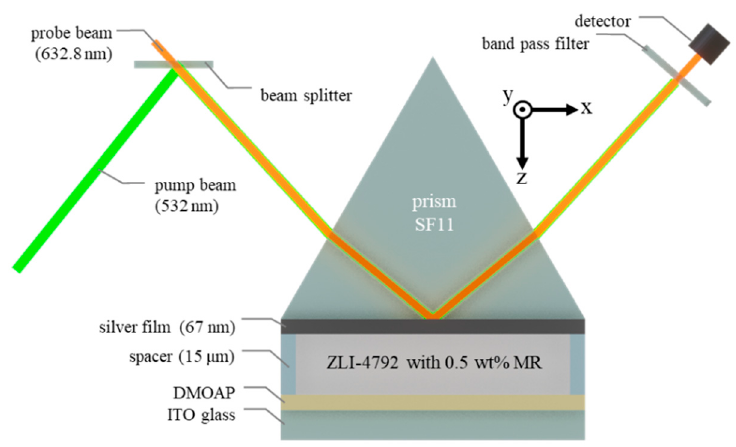
Figure 1. Kretschmann configuration of the ADDLC cell.